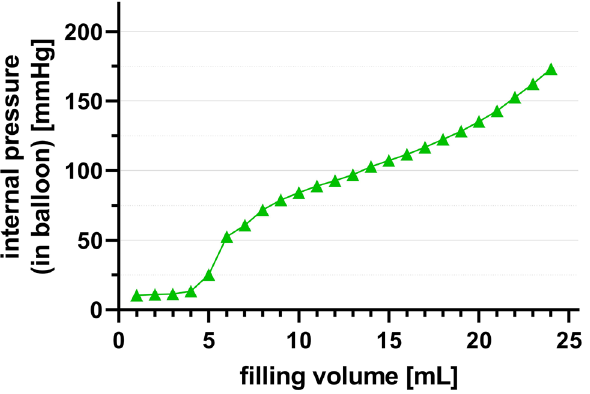
Figure 3. ER-REBOA Compliance/elastance of the balloon when suspended in air. After overcoming initial elastic recoil forces, compliance of balloon remains constant within the recommended